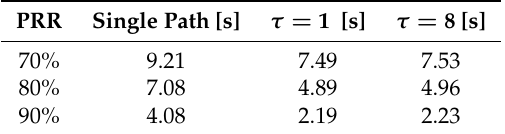
Table 4. The 99th percentile latencies for different link